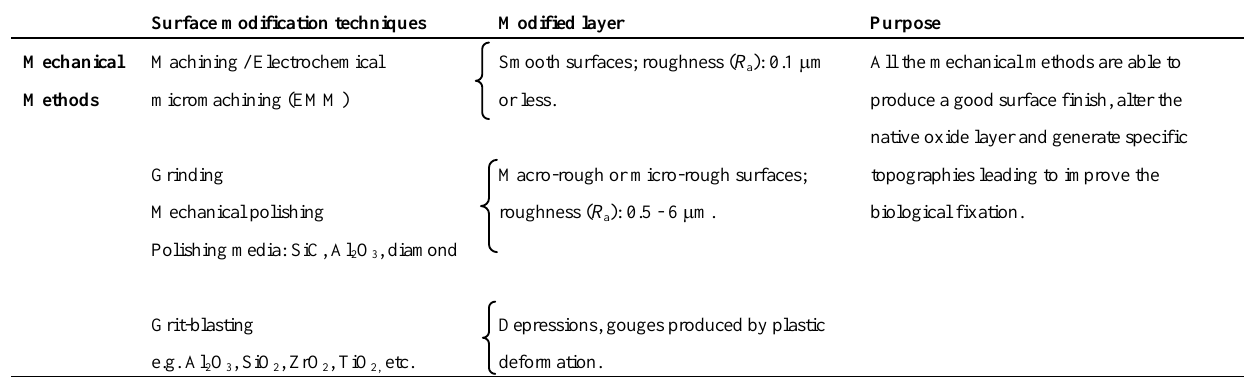
Table 2. Surface modification techniques available for pure titanium and titanium alloys. Modified from Liu X. et al.